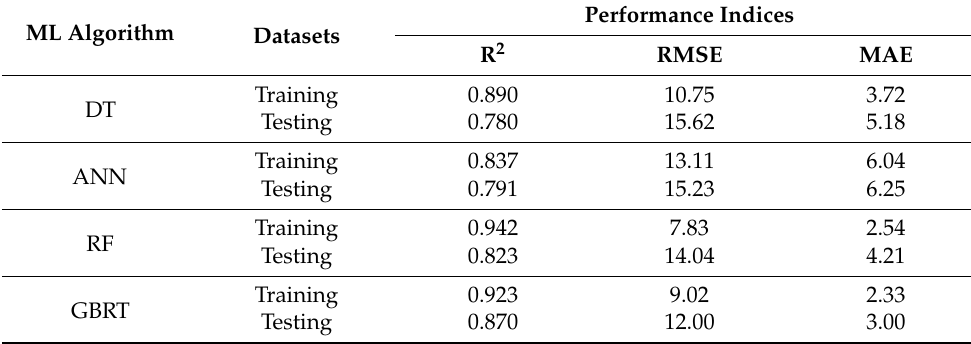
Table 8. Performance measures of four ML